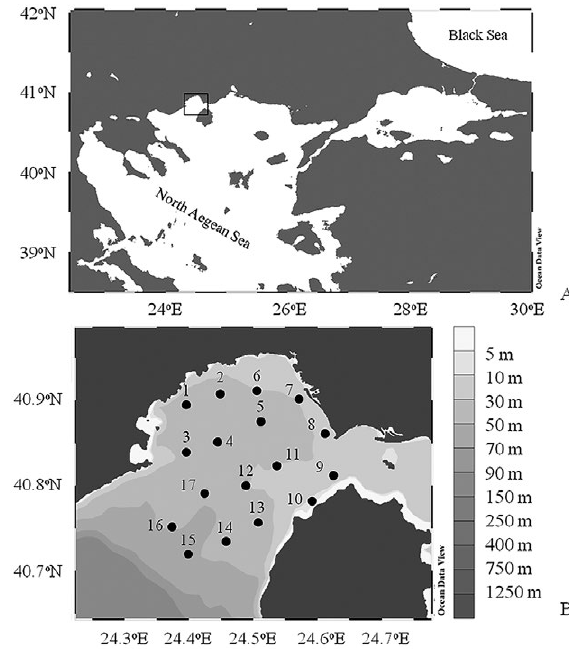
Fig. 1. – A, map of the northern Aegean Sea. Black square indicates Kavala Gulf. B, map of the sampling stations in Kavala Gulf, north- ern Aegean Sea in July 2002 and